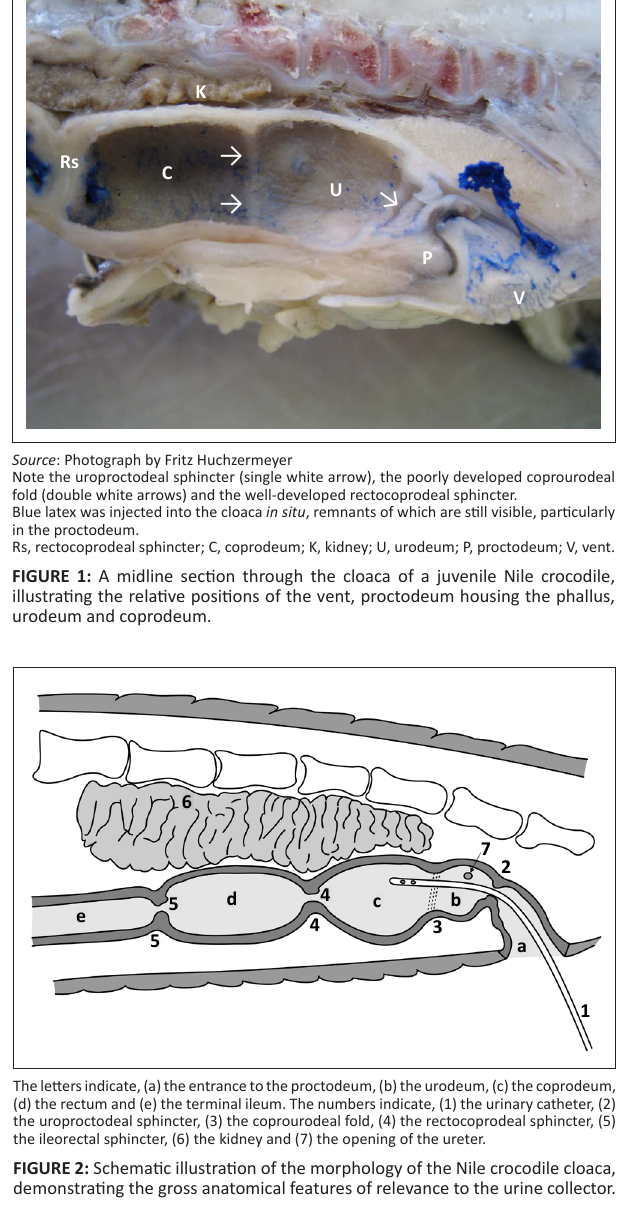
FIGURE 2: Schematic illustration of the morphology of the Nile crocodile cloaca, demonstrating the gross anatomical features of relevance to the urine collector.